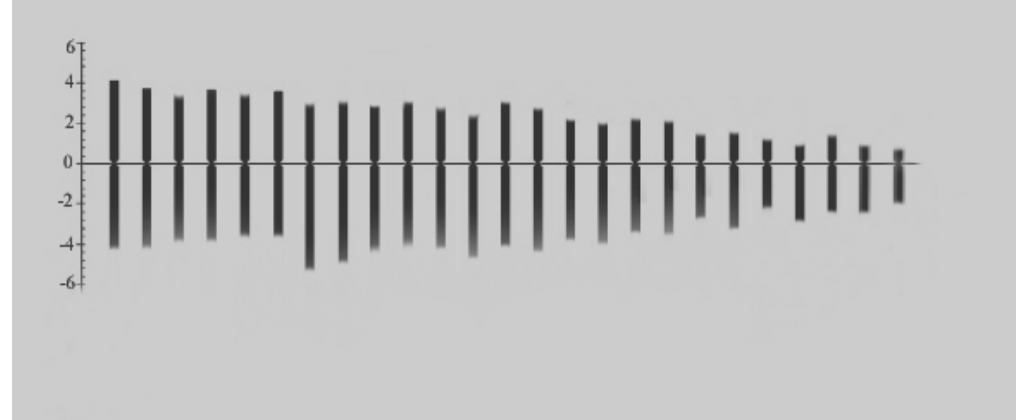
F IGURE 4. Haploid idiogram of pike ( Esox lucius ) from Anzali